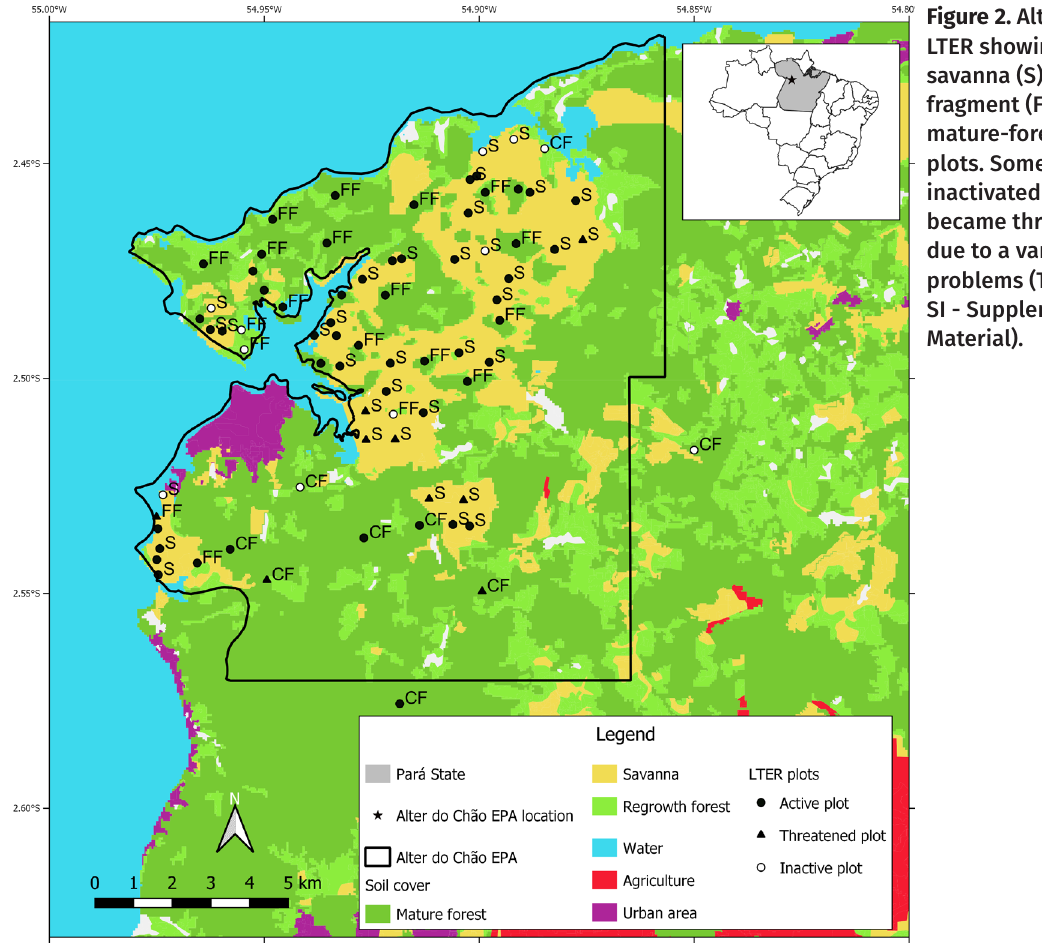
Figure 2. Alter do Chão LTER showing the savanna (S), forest- fragment (FF) and mature-forest (MF) plots. Some plots were inactivated and some became threatened due to a variety of problems (Table SI - Supplementary